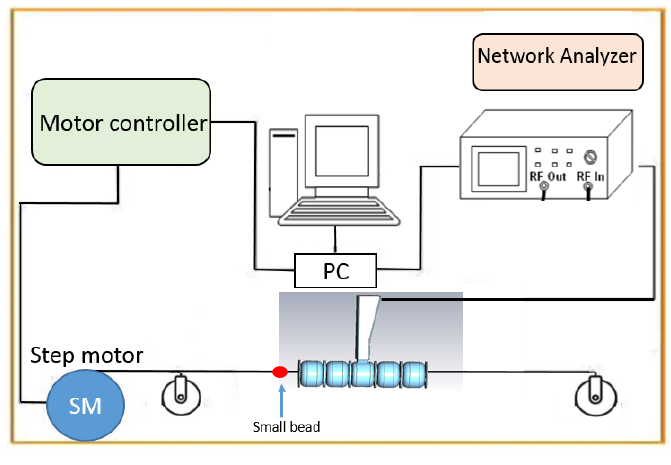
Figure 10. Sketch of the bead-pull measurement